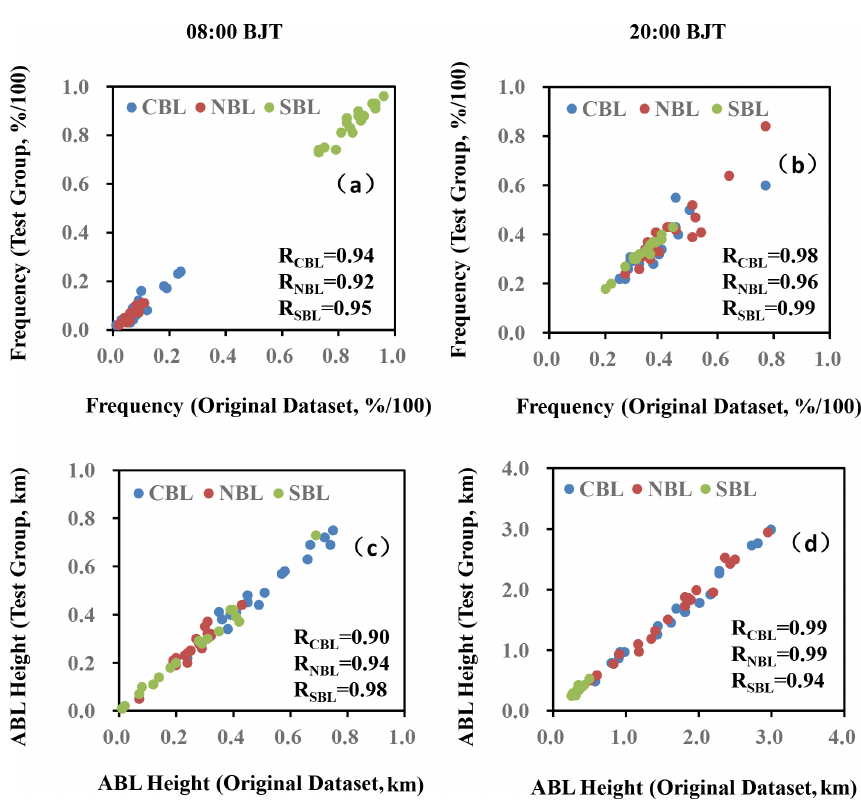
Figure 8. The scatter plots of occurrence frequency of the SBL, NBL, and CBL for the original and test group datasets at 19 stations at (a) 08:00BJT and (b) 20:00BJT; (c, d) same as in (a, b) but for the ABLH.